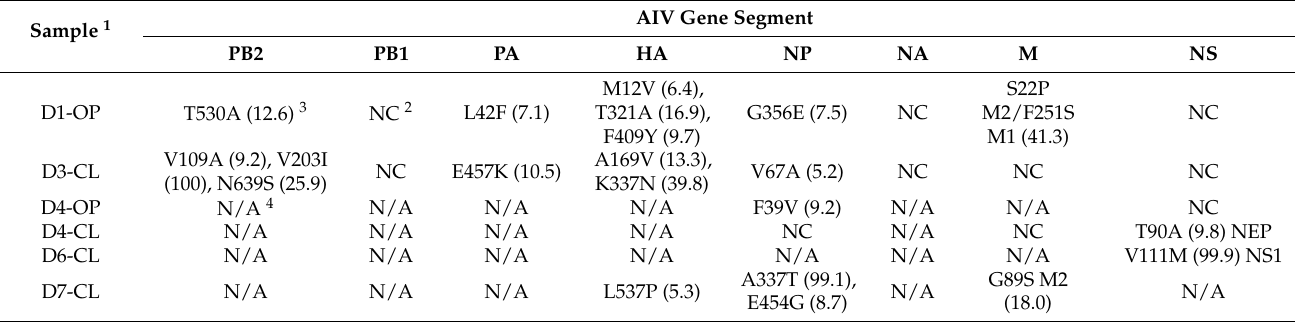
Table 3. Polymorphisms found in the A/duck/AL/2017 (H7N9) viral genome recovered from SPF layer chickens (#584) that developed severe clinical disease. Chickens were challenged with A/duck/AL/2017 (H7N9) at three weeks of age. At day 2 post challenge, one directly infected chicken (#584) exhibited more severe clinical signs, including nasal discharge, bleeding follicular conjunctivitis, and bloody diarrhea, compared to other directly infected ones. This bird recovered at 6 dpc and remained clinically healthy until the end of experiment. The frequencies of variants were computed using a minimum sequence coverage of 1000 reads per base and a minimum variant frequency of 5%. The maximum p -value of 10–6 and a minimum strand-bias p -value of 10–5 when exceeding a 65% bias were used to call the variants with an average quality >